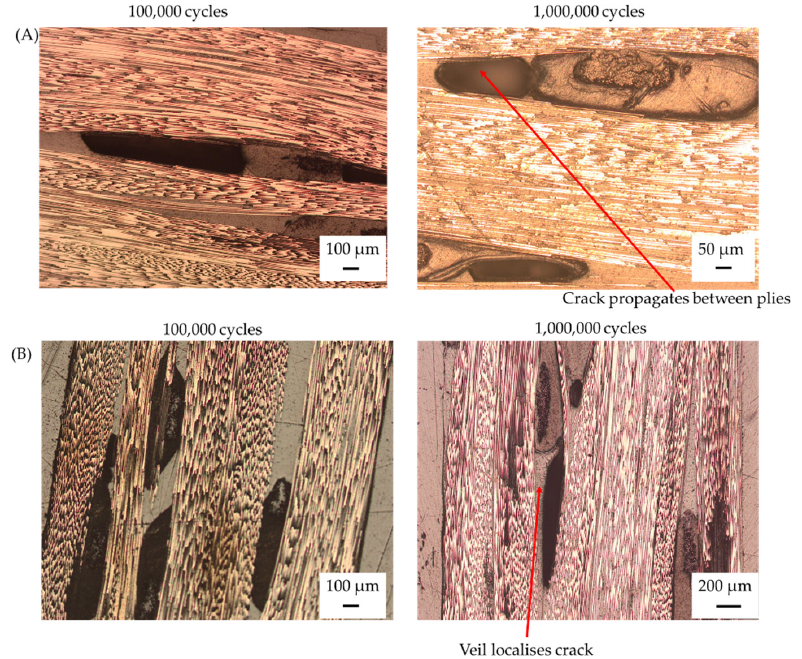
Figure 6. Total of 50% maximum flexural loading CF tested at (A) 100,000 and 1 million cycles, and (B) CFT tested at 100,000 and 1 million cycles . ( B ) CFT tested at 100,000 and 1 million cycles.